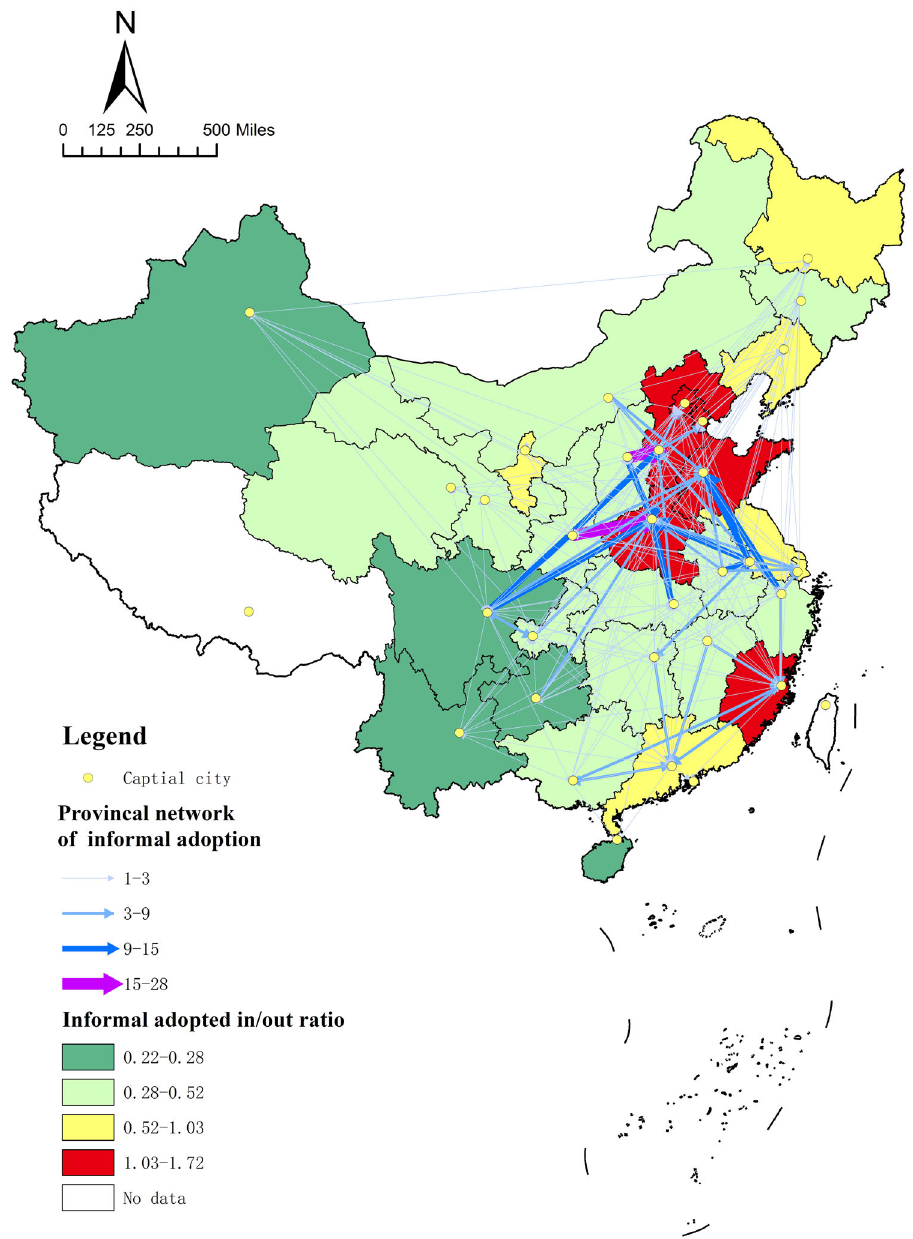
Fig. 4 Geographical migration and ratio between informal in- and out-adoptions of each province. Darker green indicates more children being adopted out of than into these provinces. Light green and yellow indicate little more children adopted out of than into these provinces. Red indicates that more children were adopted into these provinces. White indicates that the data are insuf fi cient for a province. The lines represent interprovincial informal